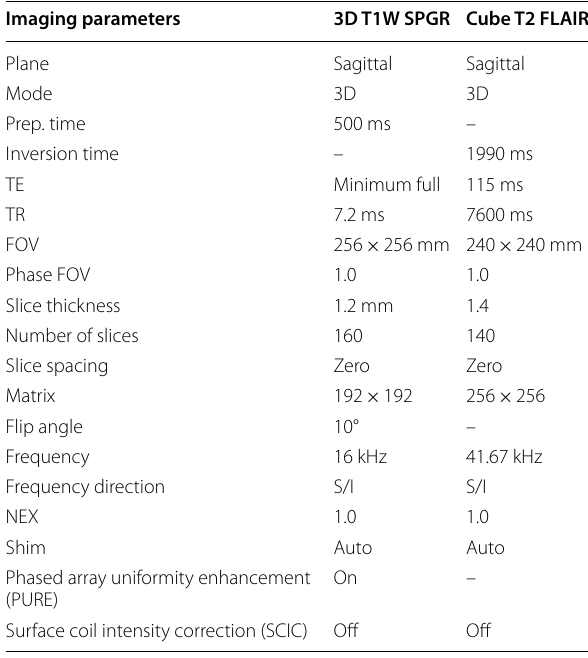
Table 1 Detailed imaging parameters used for acquiring 3D T1W and Cube T2 FLAIR sequences Imaging parameters